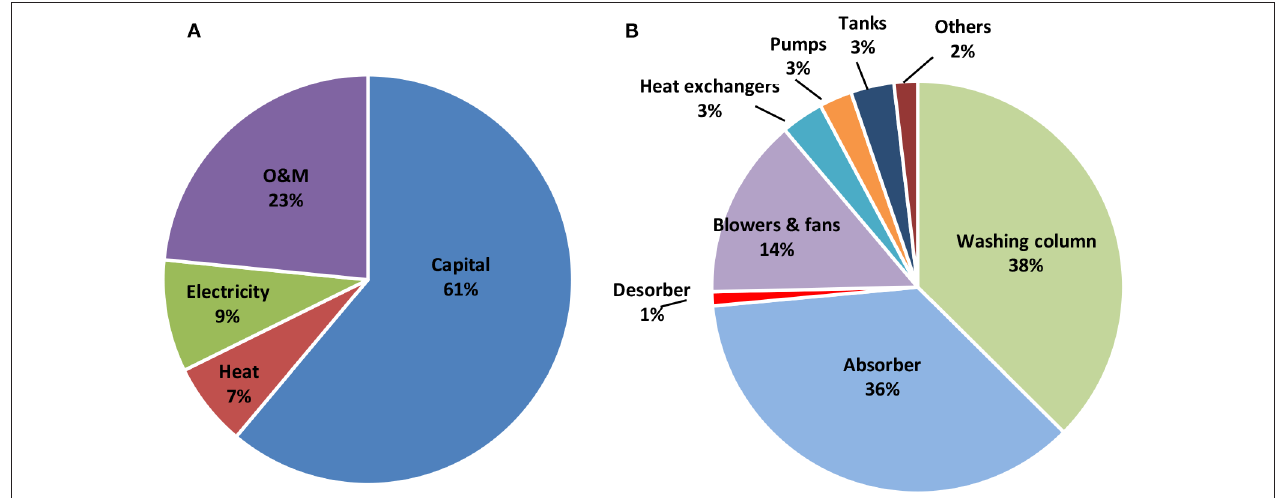
FIGURE 7 | (A) CO 2 capture cost distributions on capital, O&M, electricity and heat, and (B) capital cost distributions of major equipment in the MEA-based air capture.